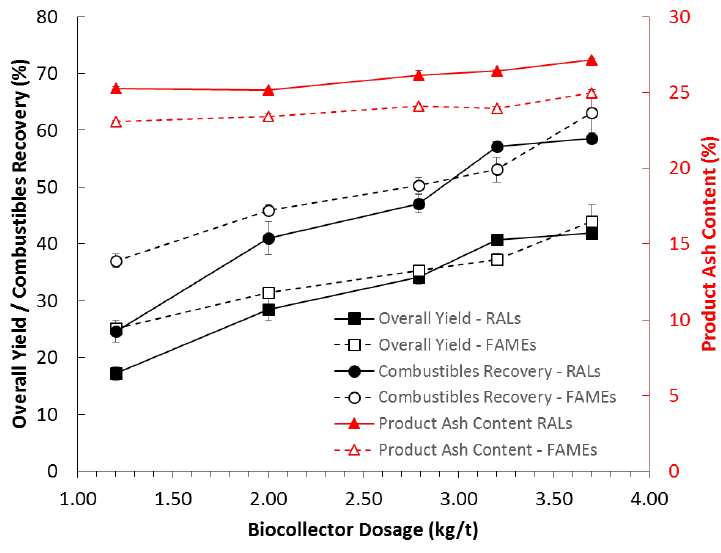
Figure 2. Overall yield, combustibles recovery and product ash content for Site 1 flotation experiments as a function of RAL and FAME dosage at pH 2.7.